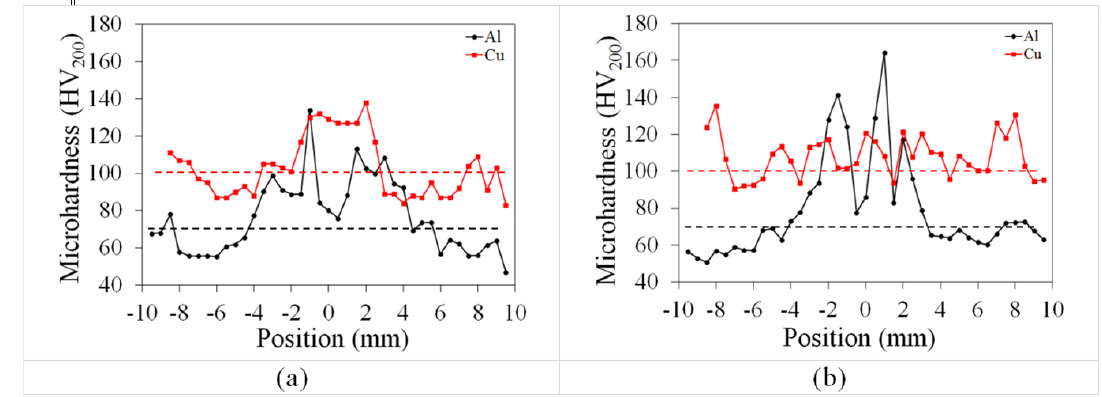
Figure 7. Microhardness profiles in cross section for WD 800/10 at (a) IS and (b) FS positions.